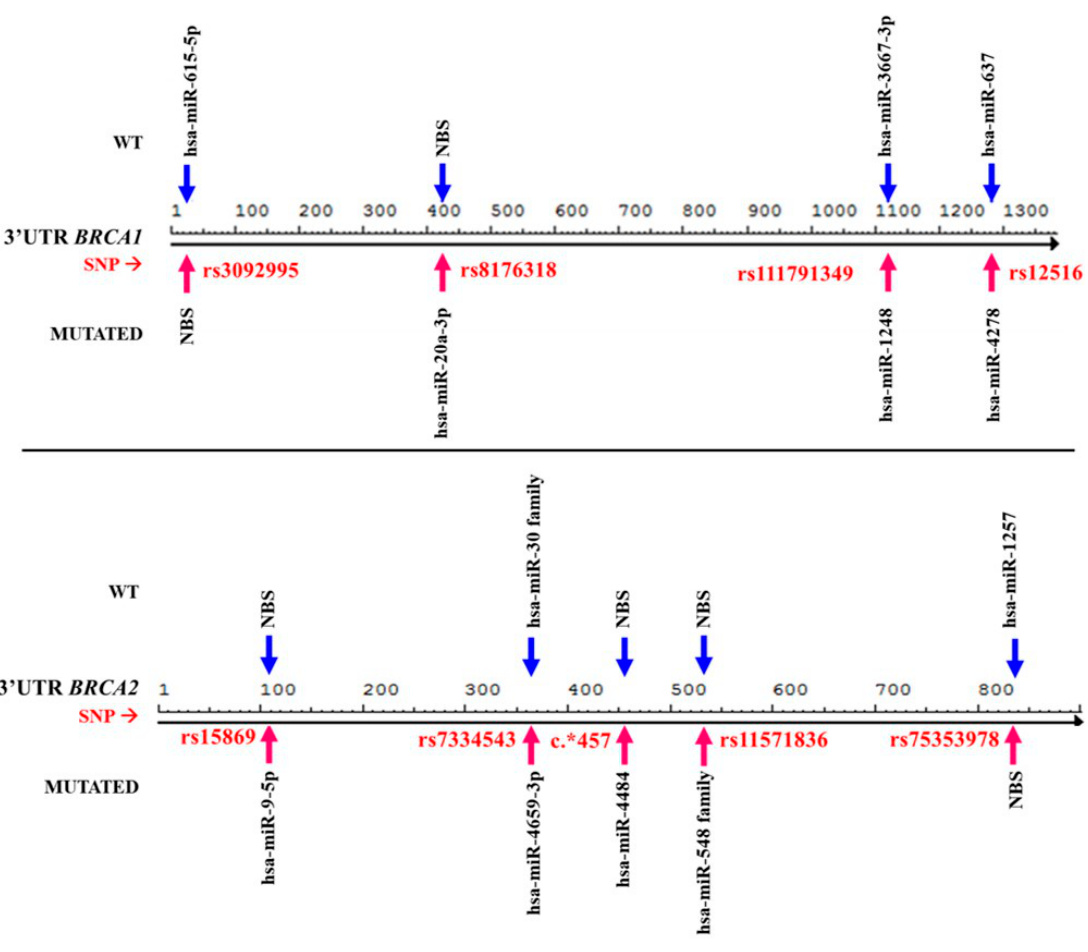
Figure 2. Comparative map of miRNAs bound between normal (WT) and mutated sequences. Trans modifications can be observed in the miRNA mechanism because of the presence of allelic variants. Arrow blue indicate miRNAs binding site in WT; Arrow red indicate miRNAs bind site into mutations. * NBS—site with no miRNA binding site. Table 5. In silico e ffect of allelic variants on the miRNAs-binding seed regions. Some SNPs modified the sequence regions of the mRNA causing the deletion or creation of miRNA binding sites. Red line indicates a new miRNA binding site created; red cross indicates that a miRNA binding site were deleted.